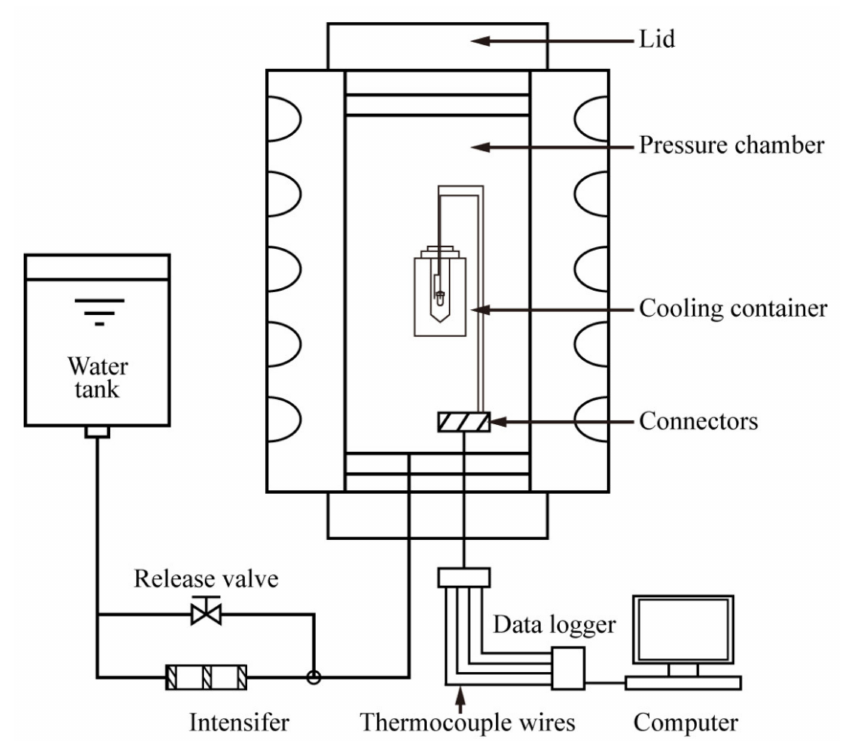
Figure 3. Schematic diagram of the high-pressure